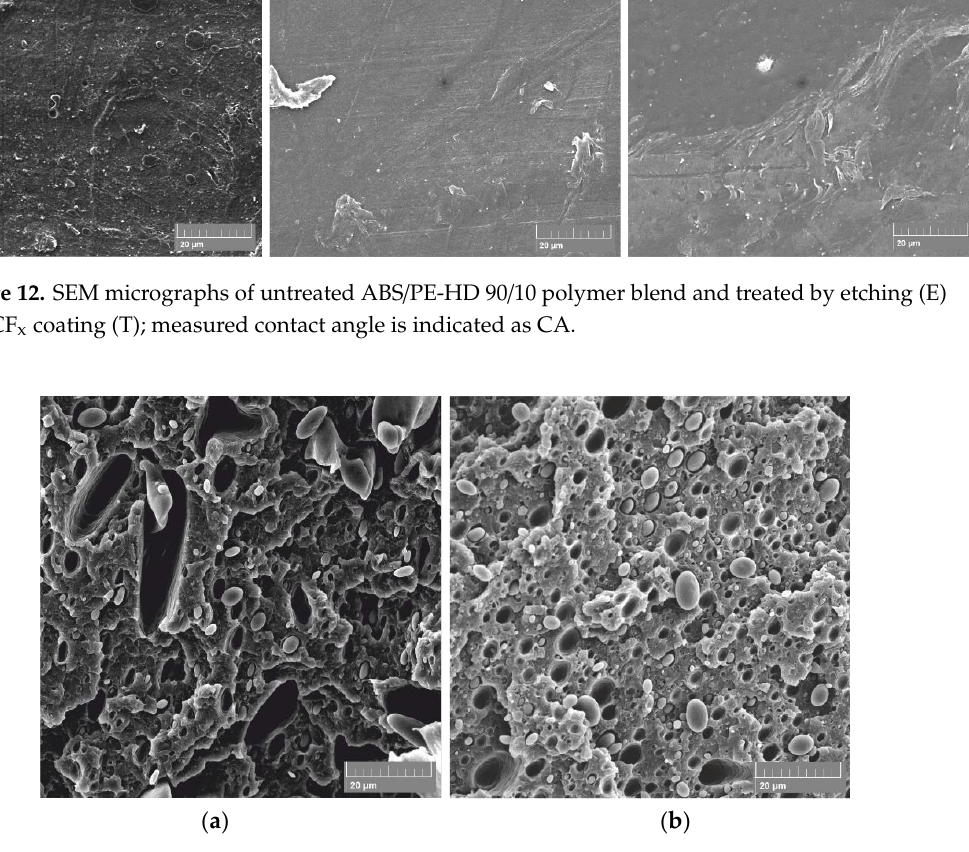
Figure 13. SEM micrographs on the fracture surface of the untreated samples; ( a ) ABS/PE-LD 90/10 and ( b ) ABS/PE-HD 90/10.